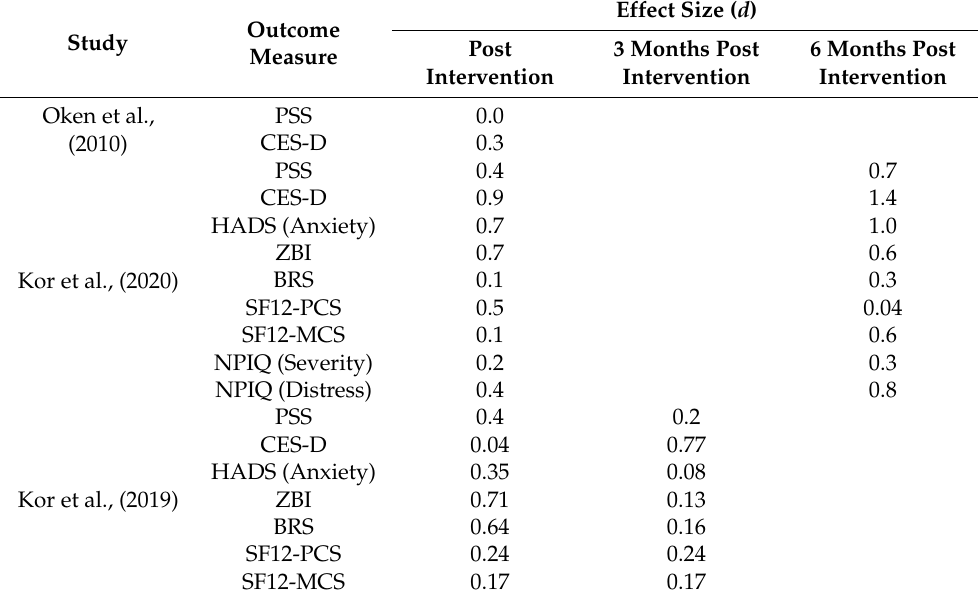
Table 2. Effect sizes of included studies. Outcome Study